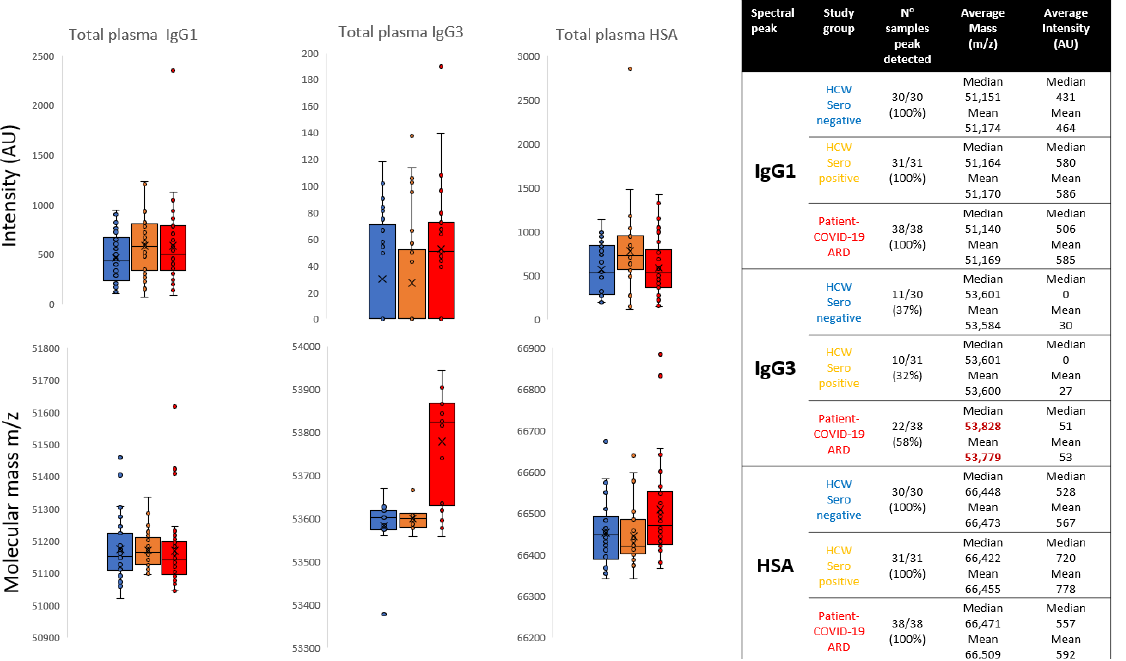
Figure 2. Box and whisker plots of relative intensitities and variance in peak apex molecular mass of IgG1 heavy chains (IgG1 Hc), IgG3 heavy chains (IgG3 Hc) and human serum albumin (HSA) for the different sample groups: Blue represents data from SARS-CoV-2 seronegative HCWs, Orange from SARS-CoV-2 seropositive HCWs having recovered from COVID-19 with mild symptoms and Red sample data from convalescent patients recovering from COVID-19 ARDS. The table to the right is numeric data from the plots detailing the mean and median values of peak intensity (arbi- trary units (AU)) and molecular mass ( m / z ) of IgG1 Hc, IgG3 Hc and HSA for the respective groups.